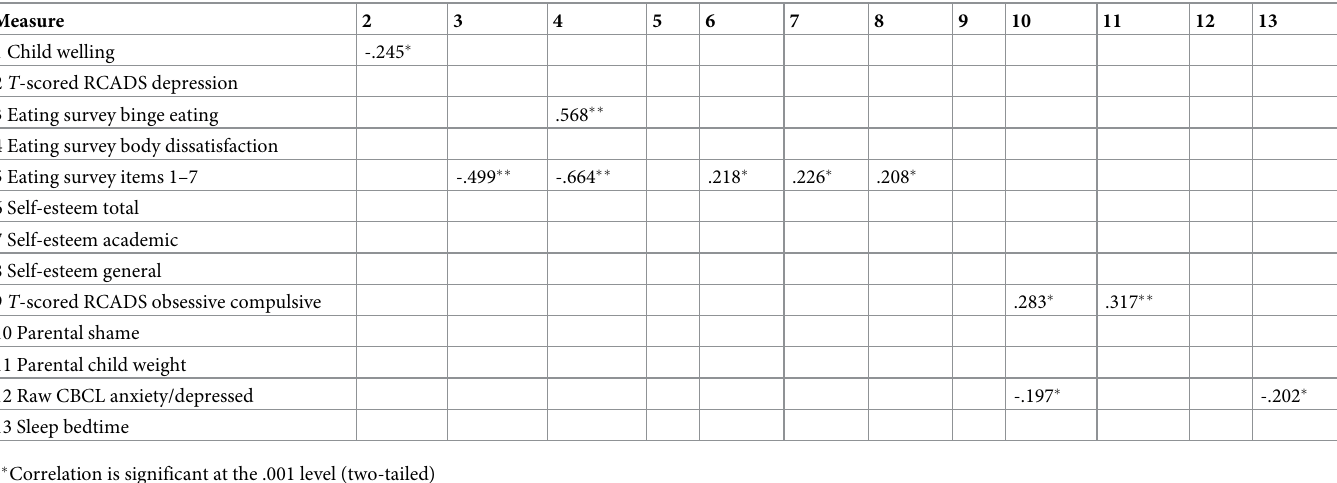
Table 11. Pearson’s correlations for control group mental health and wellbeing variables. Measure